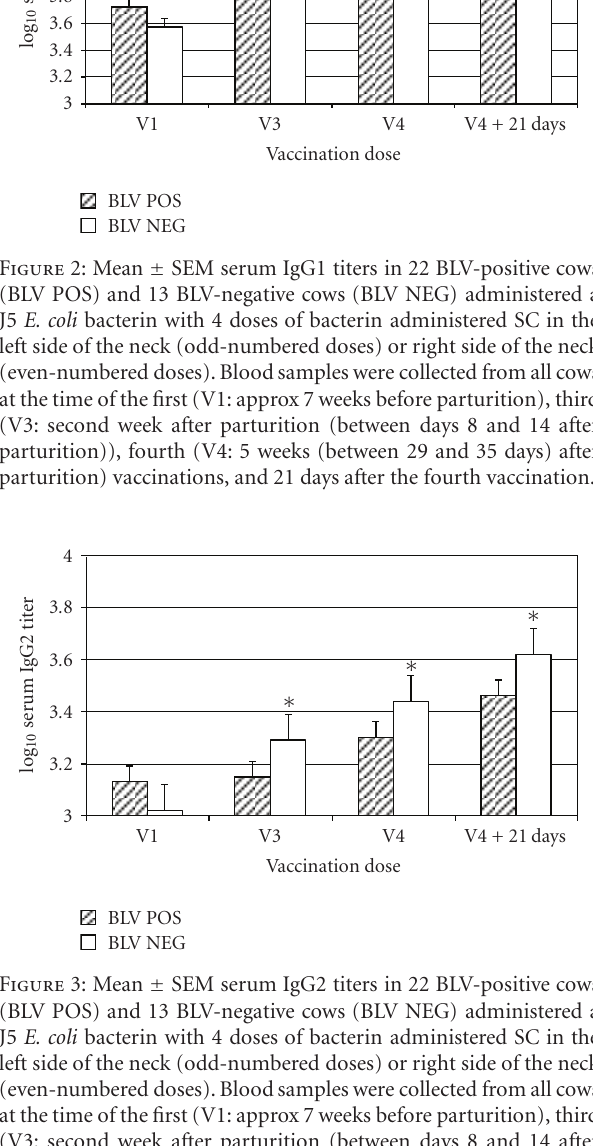
Figure 3: Mean ± SEM serum IgG2 titers in 22 BLV-positive cows (BLV POS) and 13 BLV-negative cows (BLV NEG) administered a J5 E. coli bacterin with 4 doses of bacterin administered SC in the left side of the neck (odd-numbered doses) or right side of the neck (even-numbered doses).Blood samples were collected from all cows at the time of the first (V1: approx 7 weeks before parturition), third (V3: second week after parturition (between days 8 and 14 after parturition)), fourth (V4: 5 weeks (between 29 and 35 days) after parturition) vaccinations, and 21 days after the fourth vaccination. ∗ Within a time point, mean values for groups di ff er significantly ( P < .